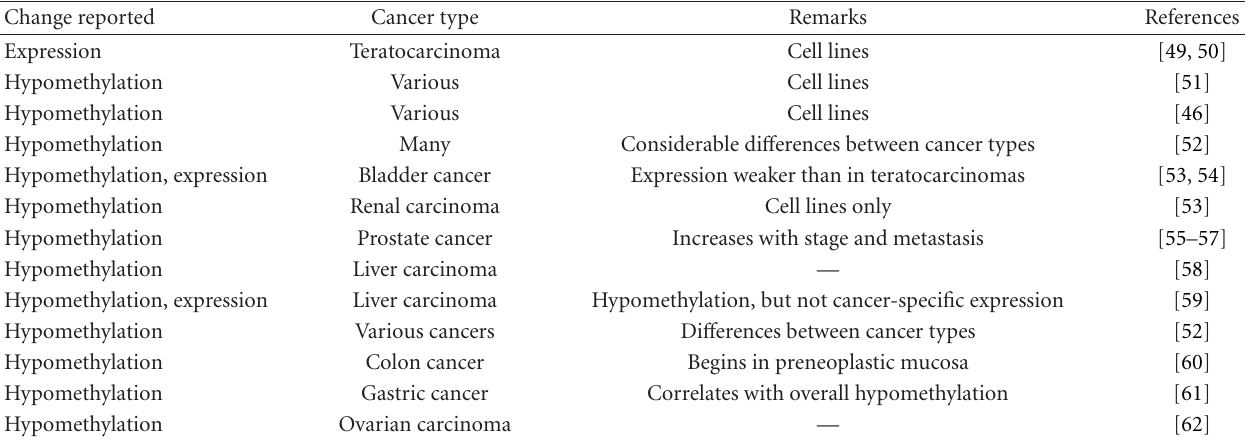
Table 1: Hypomethylation and expression of L1 in human